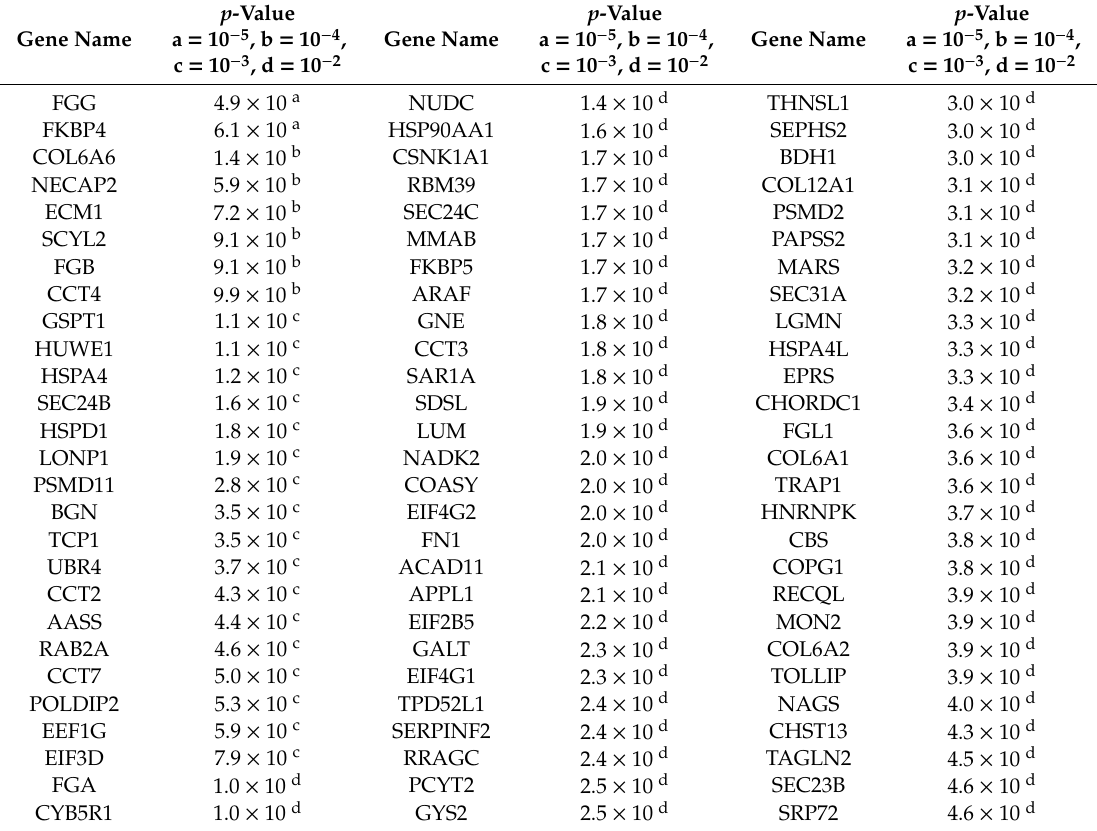
Table 1. Significantly abundant proteins in decellularized healthy scaffolds.